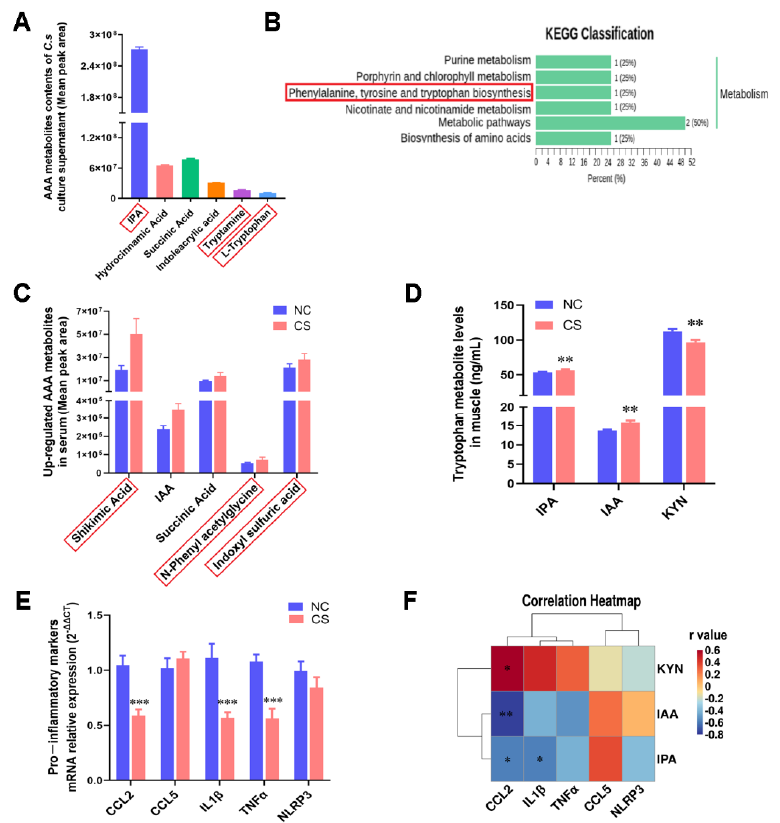
Figure 2. C. sporogenes altered AAA metabolism and reduced pro-inflammatory cytokine expression. ( A ) The top 6 AAA metabolites in C. sporogenes cell suspensions; the red box highlights the metabolites associated with tryptophan metabolism and the same below in this figure. ( B ) KEGG enrichment analysis of all differentially expressed metabolite. ( C ) The upregulation of key AAA metabolites in mice serum. ( D ) Levels of tryptophan metabolites IPA, IAA, and KYN in gastrocnemius tissues. ( E ) The mRNA levels of pro-inflammatory cytokines markers (CCL2, CCL5, IL-1 β , TNF α , NLRP3) in the gastrocnemius tissue. ( F ) Correlation analysis of tryptophan metabolites (IPA, IAA, KYN) with pro-inflammatory cytokines (CCL2, CCL5, IL-1 β , TNF α , NLRP3) in the gastrocnemius tissue. Unmarked graphs show no significant difference. The data shown are the means ± SEM, n = 6. * p < 0.05, ** p < 0.01, and *** p < 0.001.